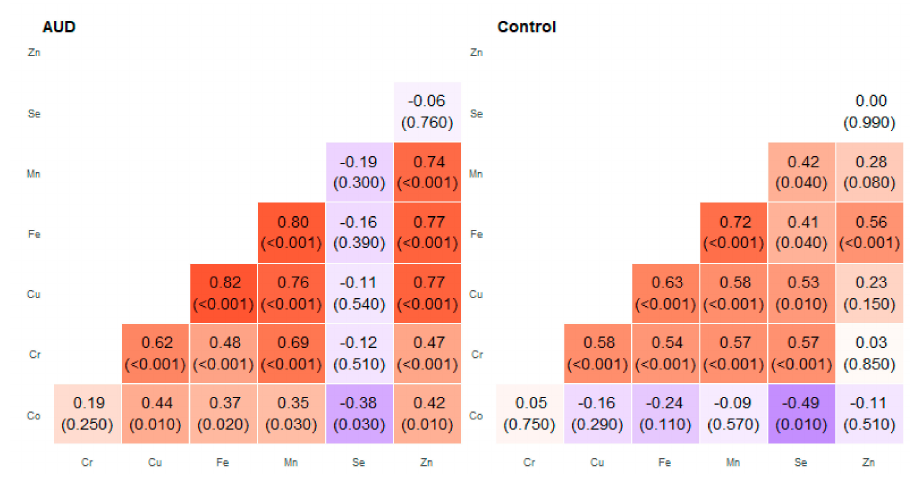
Figure 9. Correlation matrix of Spearman coe ffi cient charts in the post central gyrus region in the alcohol use disorder and control groups.